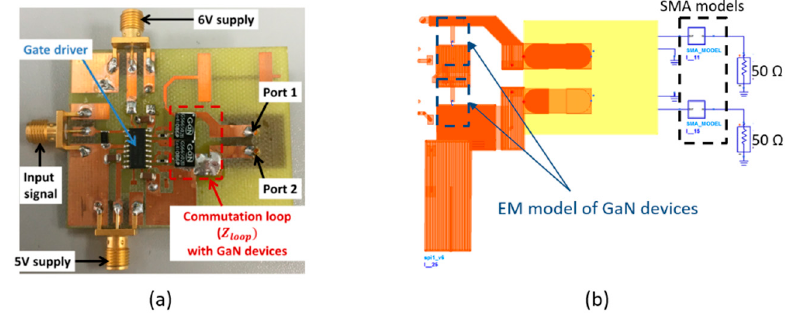
Figure 16. Lateral commutation loop: ( a ) test fixture; ( b ) simulation setup.